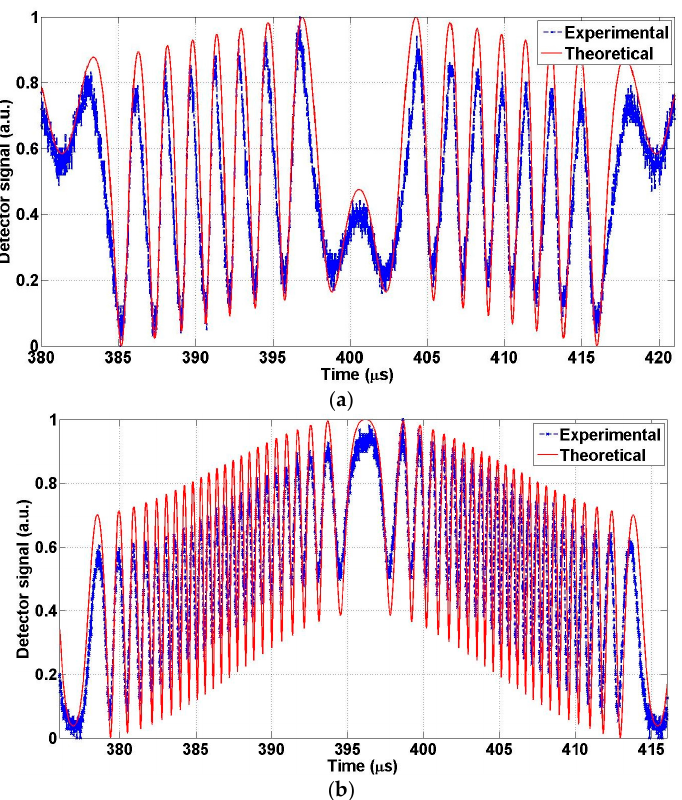
Figure 13. Optical interferogram obtained using actuator A and the corresponding theoretical response using best fit for the actuator travel range. ( a ) Under applied voltage of about 36 V direct current (DC) and 9.5 V alternating current (AC); ( b ) Under applied voltage of about 114 V DC & 4.5 V AC.